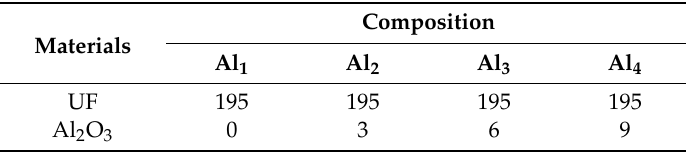
Table 2. Composition of Al 2 O 3 -UF nanofillers.